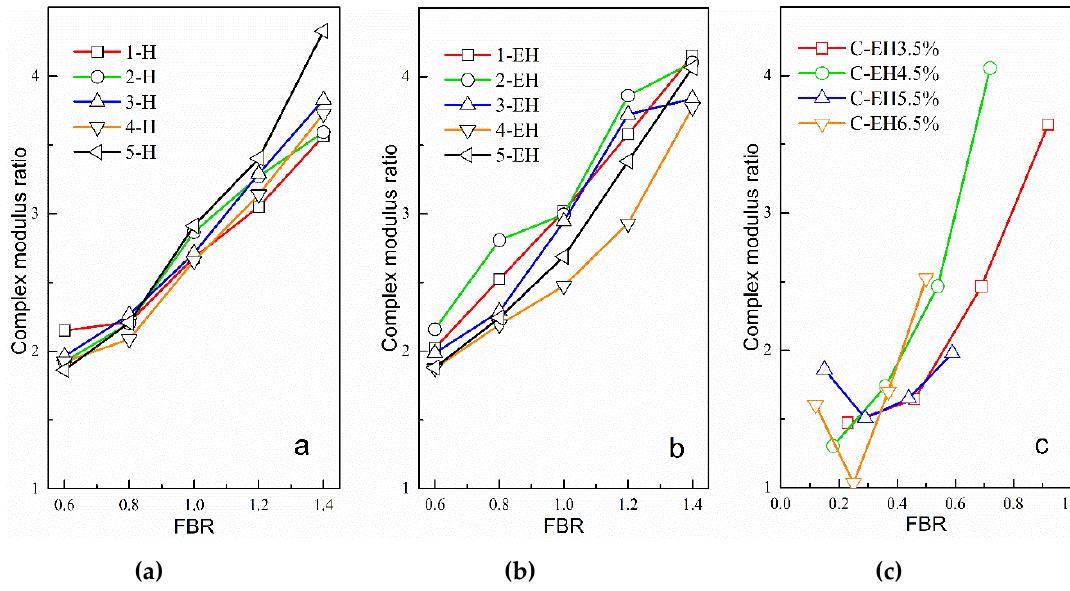
Figure 3. Relationship between mastic modulus and FBR. ( a ) Mineral filler-asphalt mastic ( b ) Mineral filler-residue mastic ( c ) Cement-residue masticAs can be seen in Figure 3, the modulus of the three types of mastics were all higher than those of matrix asphalt or EAR, and the modulus of the mineral filler-asphalt mastic specimen increased linearly with increases in FBR. When the FBR was 0.6, the five kinds of mineral filler doubled the increase, and when the FBR was 1.4, the mineral filler increased the modulus by more than double. The mineral filler-residue mastic exhibited a similar pattern to the mineral filler-asphalt mastic. This result is related to the hardening of inorganic mineral fillers; that is, the addition of mineral filler can increase the elastic recovery modulus of mastics, causing them to exhibit very linear growth relationships, and enhancing the mastics’ resistance to deformation [29].